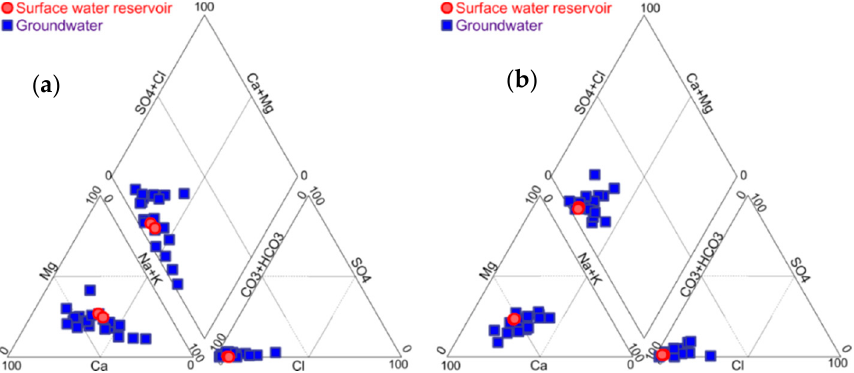
Figure 9. Chemical composition of the surface water reservoir in the dry ( a ) and rainy ( b ) seasons within Kierma watershed.